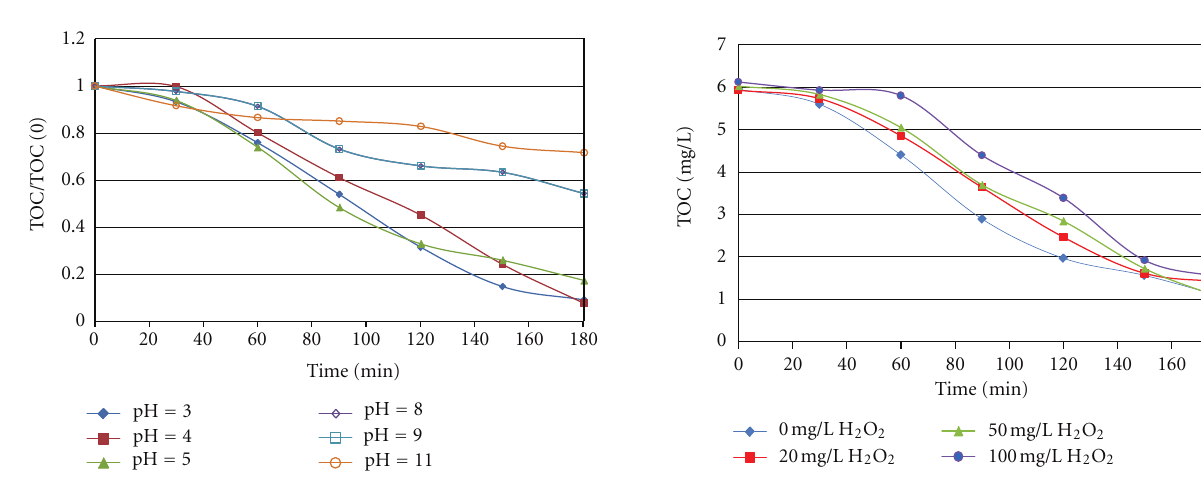
Figure 7: Heterogeneous photocatalysis of mepiquat chloride in the presence of TiO 2 P-25 and H 2 O 2 (initial conditions: 10 ppm mepiquat chloride, 0.5g/L TiO 2 P-25, UV-A lamp).